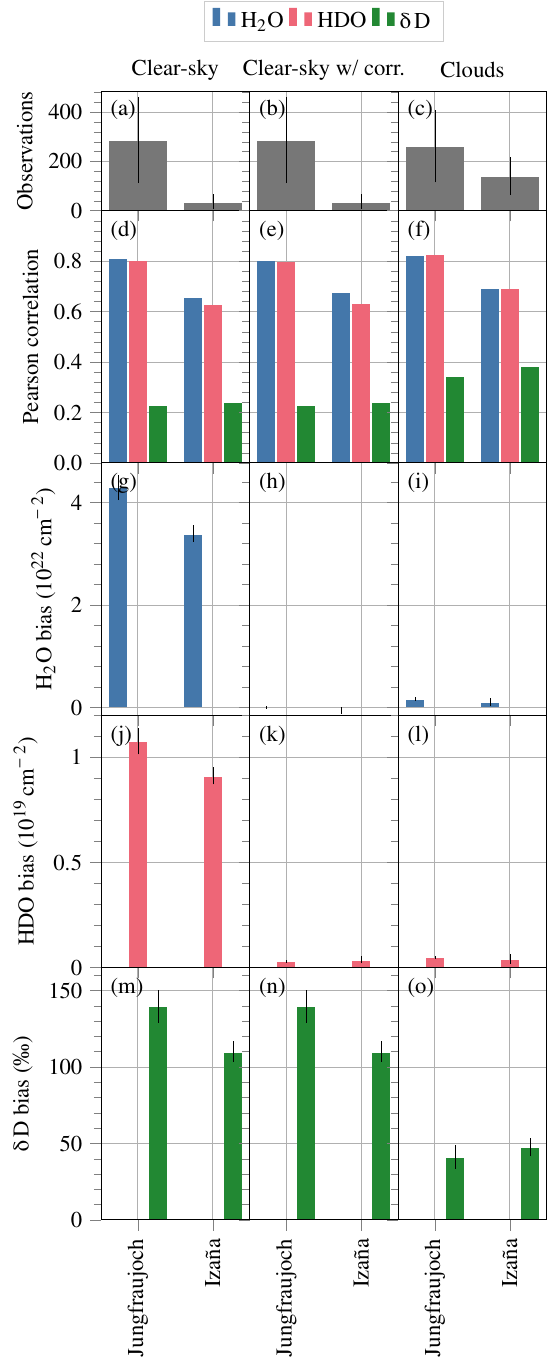
Figure 10. Like Fig. 5 but for cloud retrievals for high-altitude sta- tions. Panels (a) , (d) , (g) , (j) and (m) show results for clear-sky measurements without altitude correction; (b) , (e) , (h) , (k) and (n) show those for clear-sky observations with altitude correction; and (c) , (f) , (i) , (l) and (o) show those for altitude-corrected observations with optically thick clouds within the station height plus or minus